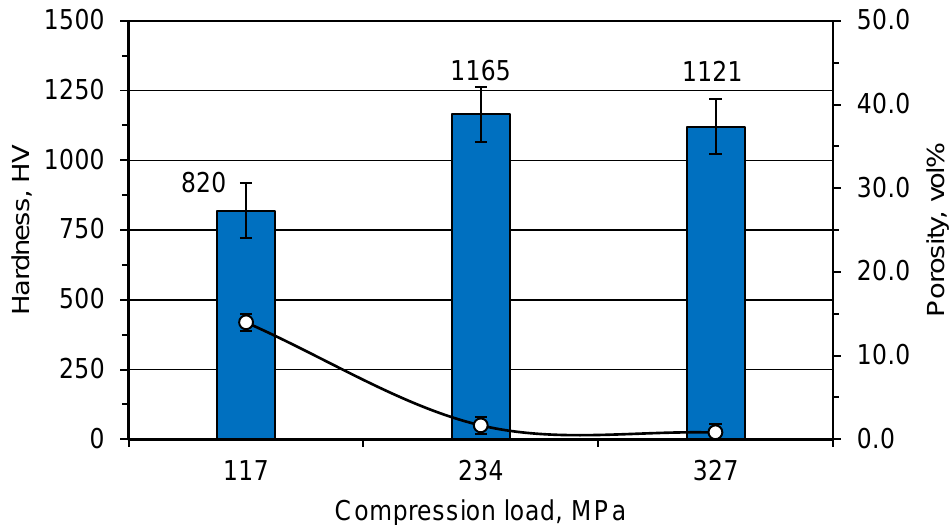
Figure 8. Effect of compression load on the 20 wt% ZrO 2 -samples’ porosity, bulk and apparent densities.